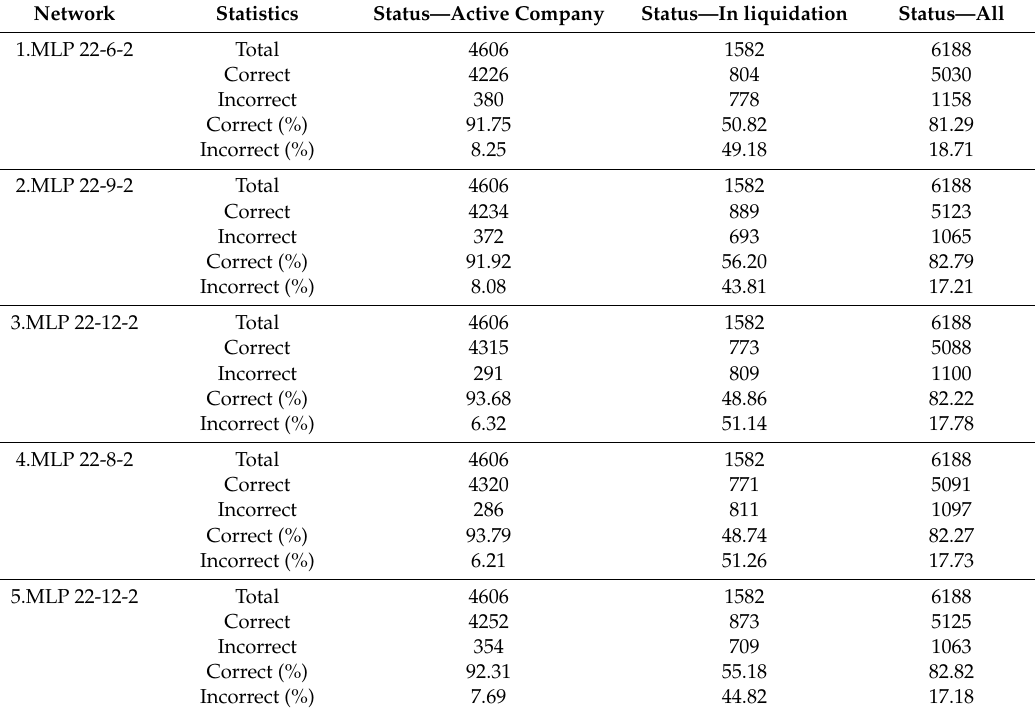
Table 5. Predictions of artificial neural